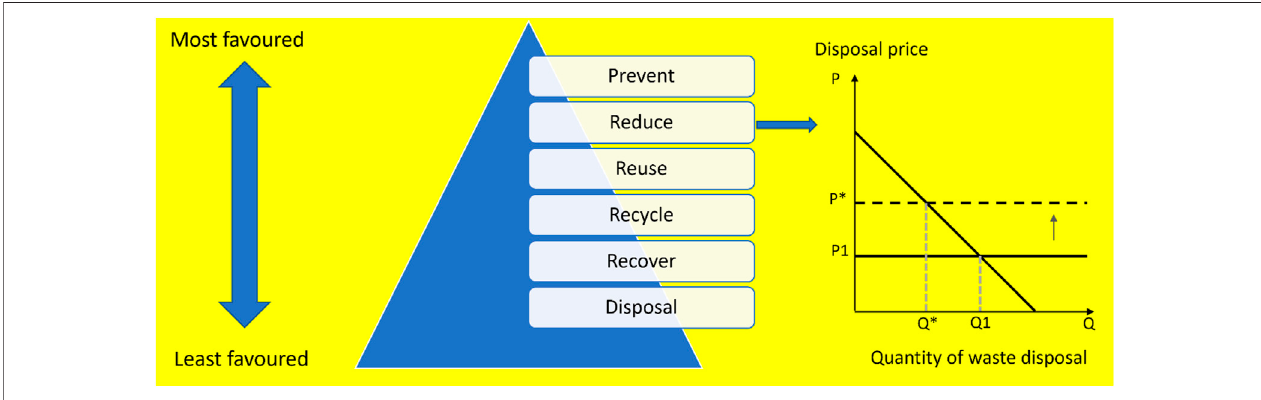
FIGURE 1 | Waste hierarchy and the economic foundation of the waste charging